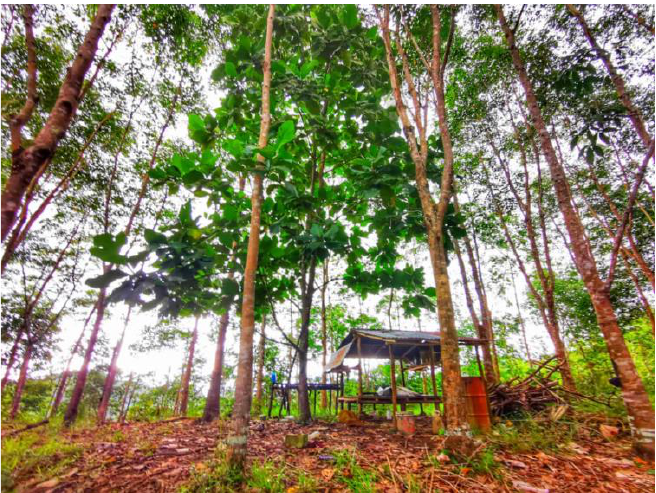
Figure 9. The “ sulap ” .